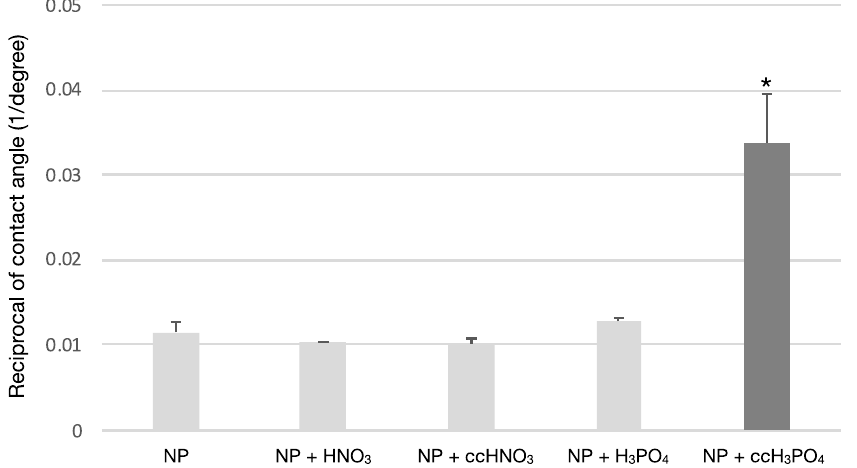
Figure 1. The effect of surface treatments on the wettability of NP surface. The treatment of the NP surface using ccH 3 PO 4 has significantly increased the wettability compared to the untreated control ( p* = 0.00). The other etchants did not cause an apparent effect on the wettability of the NP surface. Table 3. Results of contact angle measurement. The ccH 3 PO 4 treatment of NP surface significantly reduced the contact angle ( p * = 0.00). The reciprocal of the mean and standard deviation (SD) values concerning contact angle were calculated for a better visualization of the results in Figure 1. Contact Angle ( ◦ ) Reciprocal of Contact Angle (1/Degree) Treatments Table 4. Surface roughness measured using AFM. Three regions of interest (ROI) were randomly selected on the untreated control and two on the ccH 3 PO 4 -treated NP surface for analysis. The treat- ment of NP surface with ccH 3 PO 4 did not affect the surface roughness apparently.